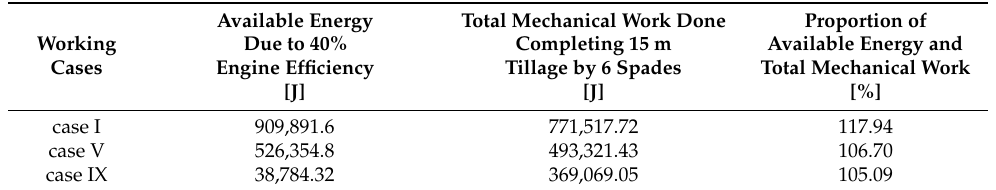
Table 5. Numerical comparison of the obtained